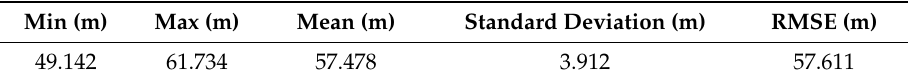
Table 4. Statistical values of CP residuals resulting from the ortho-rectified imagery and original imagery comparison.